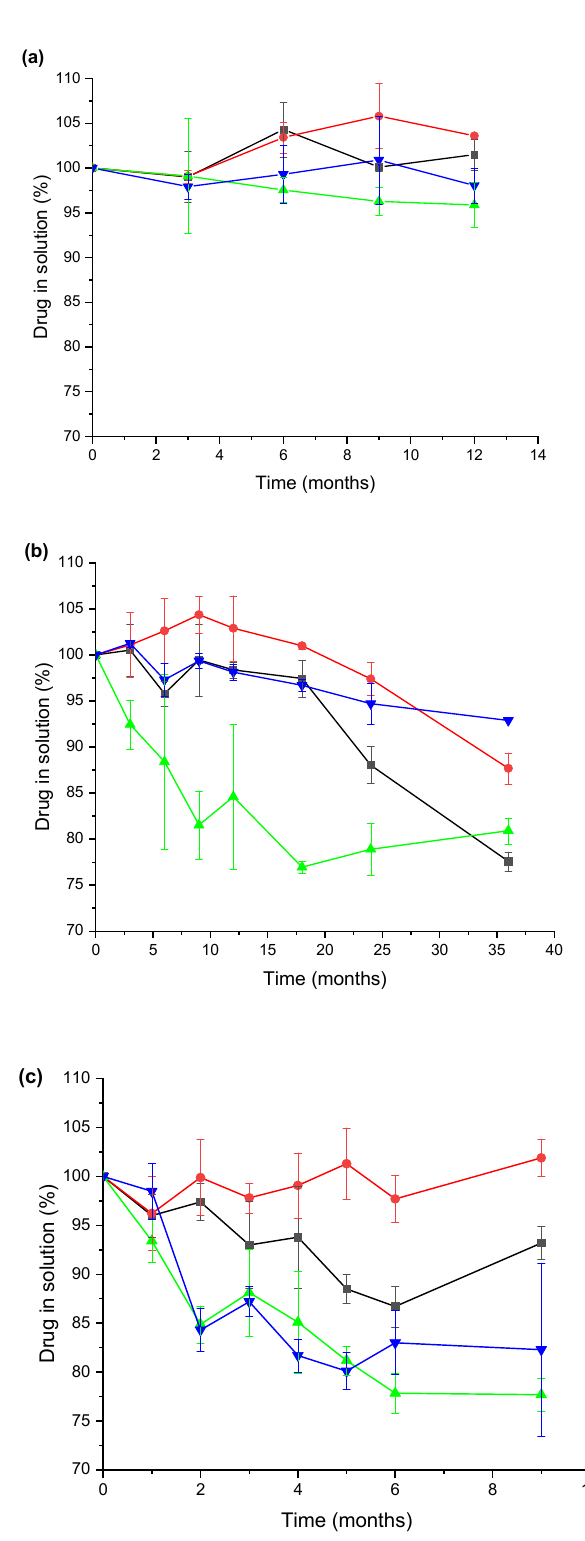
Figure 5. Drug recovery in solution under different storage conditions: ( a ) 4 ◦ C, ( b ) 25 ◦ C, and ( c ) 40 ◦ C. Key: - (cid:4) —DJEA, diazepam in sealing type PH 701/50 C BLACK, red; - • —DJEN, diazepam in sealing type 4023/50 GRAY; - (cid:78) —MJEA, midazolam in sealing type PH 701/50 C BLACK; and - (cid:72) —MJEN, midazolam in sealing type 4023/50 GRAY.